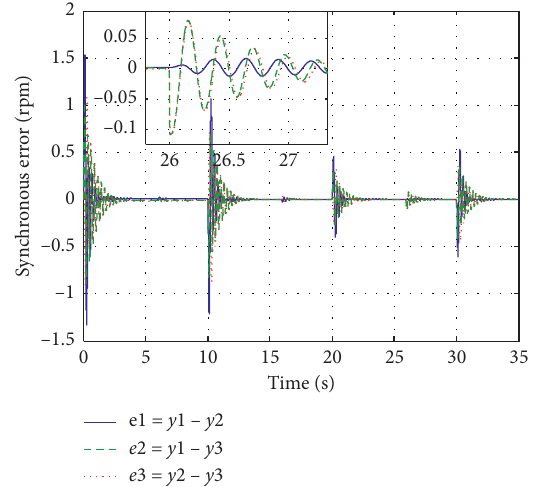
Figure 6: Tolerance synchronous output error. Table 2: Sensor failure information. Sensor